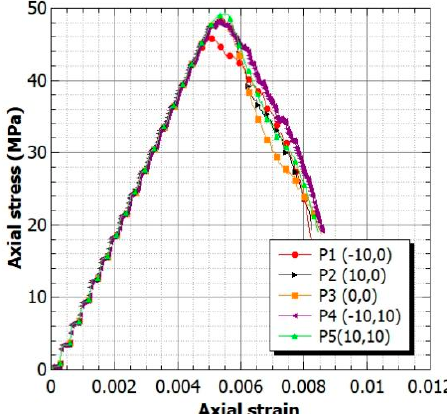
Figure 10. Axial stress, axial strain curves of tested specimens in Group 3 .